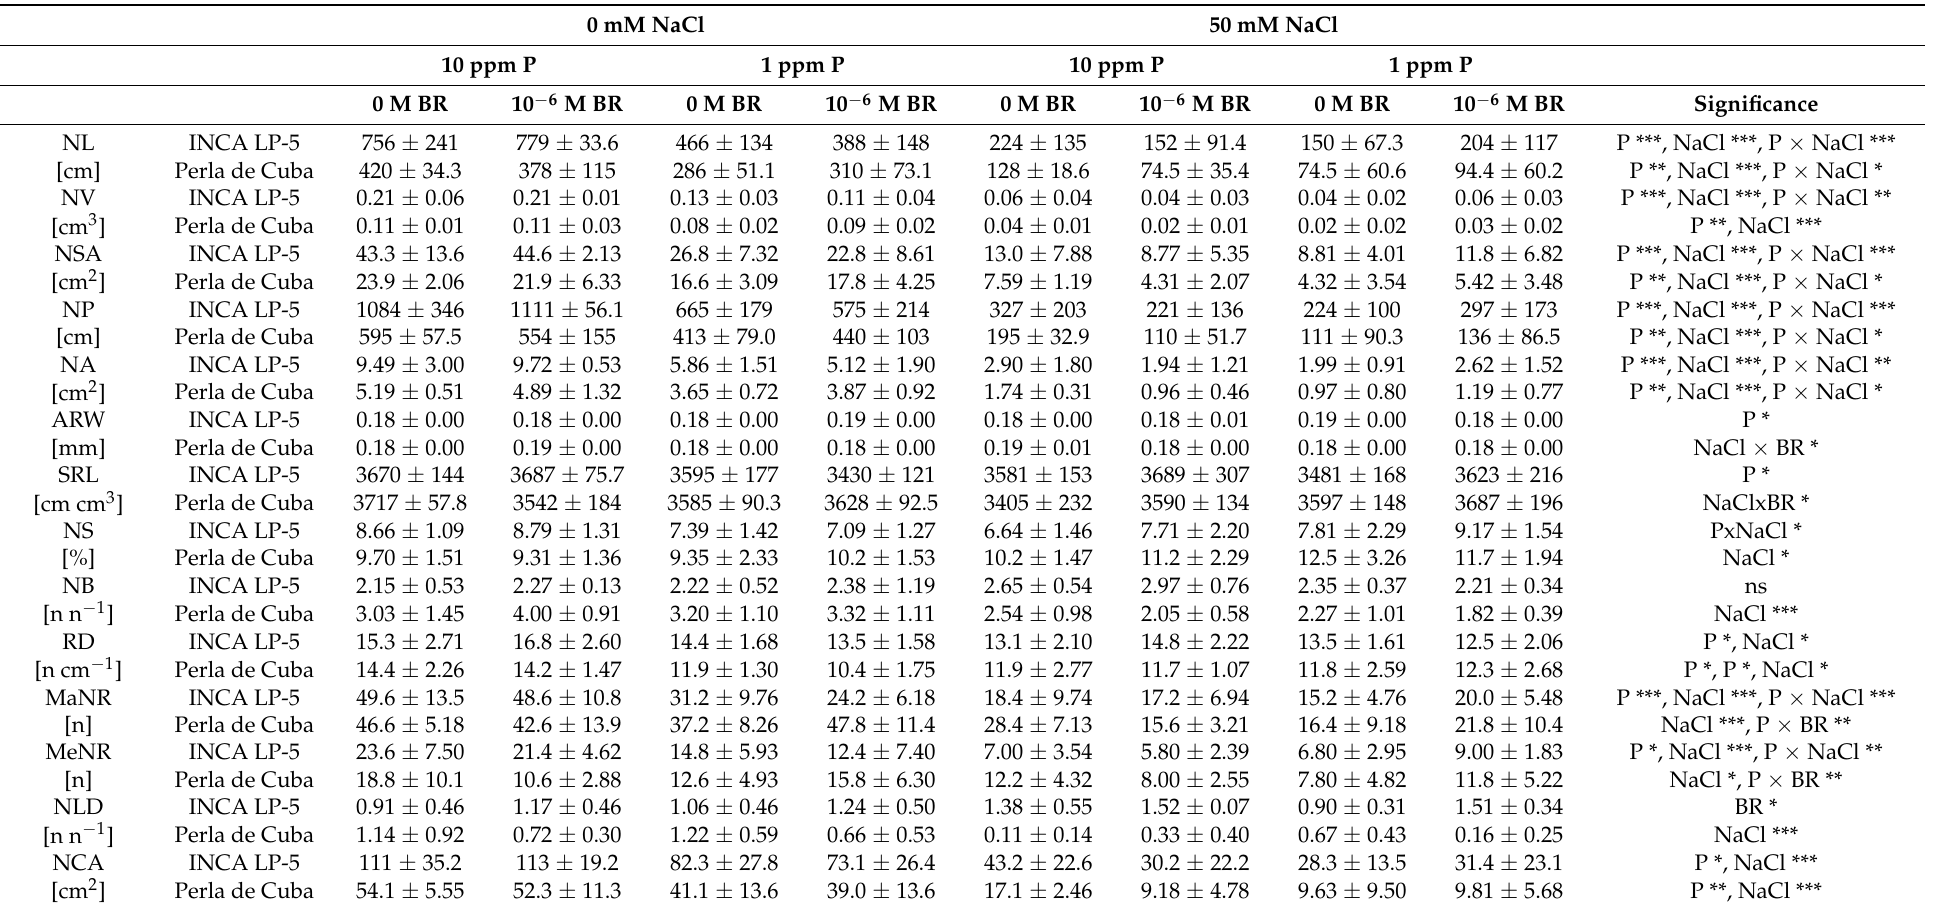
Table A1. Root-system traits of the two rice genotypes INCA LP-5 and Perla de Cuba after three weeks of growth in mini-rhizotrons (mean ± SD). Significant differences between treatments of phosphorus (P), salt (NaCl), 24-epibrassinolide (BR) and their interactions after ANOVA are shown by asterisks ( p < 0.05 * 0.01 ** 0.001 ***; p > 0.05 ns). NL: network length; NV: network volume; NSA: network surface area; NP: network perimeter; NA: network area; ARW: average root width; SRL: specific root length; NS: network solidity; NB: network bushiness; RD: lateral root density; MaNR: maximum number of roots; MeNR: median number of roots; NLD: network length distribution; NCA: network convex area; MaEA: major ellipse axis; MiEA: minor ellipse axis; ND: network depth; NW: network width; EAR: ellipse axis ratio; NWDR: network width-to-depth ratio; RA: root